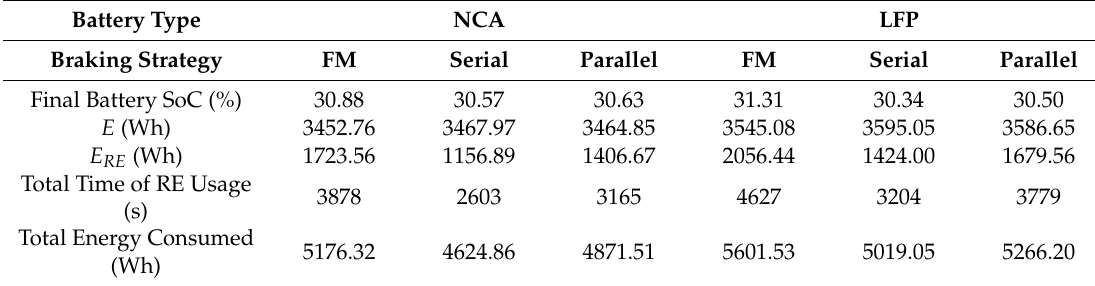
Table 8. Results for the 20 kg RE case for the complete route.